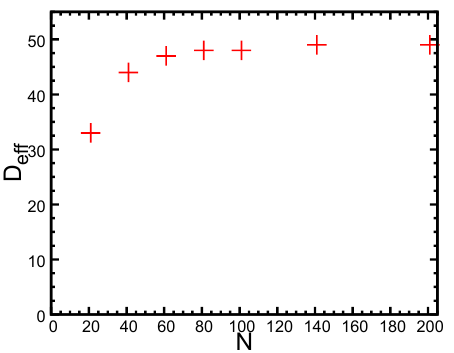
Figure 11 . The system size ( N ) dependence of the effective bond dimension with a = 0 . 05 , m lat . = 0 . 00 , θ/ (2 π ) = 0 . 00 for the charge q = 3 case at the 10th sweep.